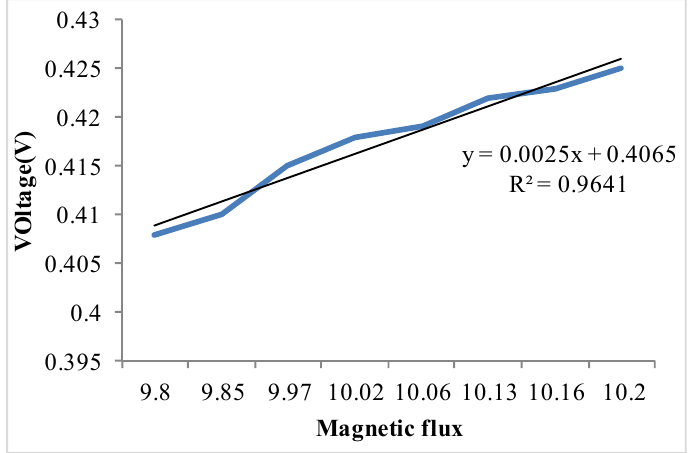
Figure 14. Magnetic flux (Input) vs . voltage (Output) curve.